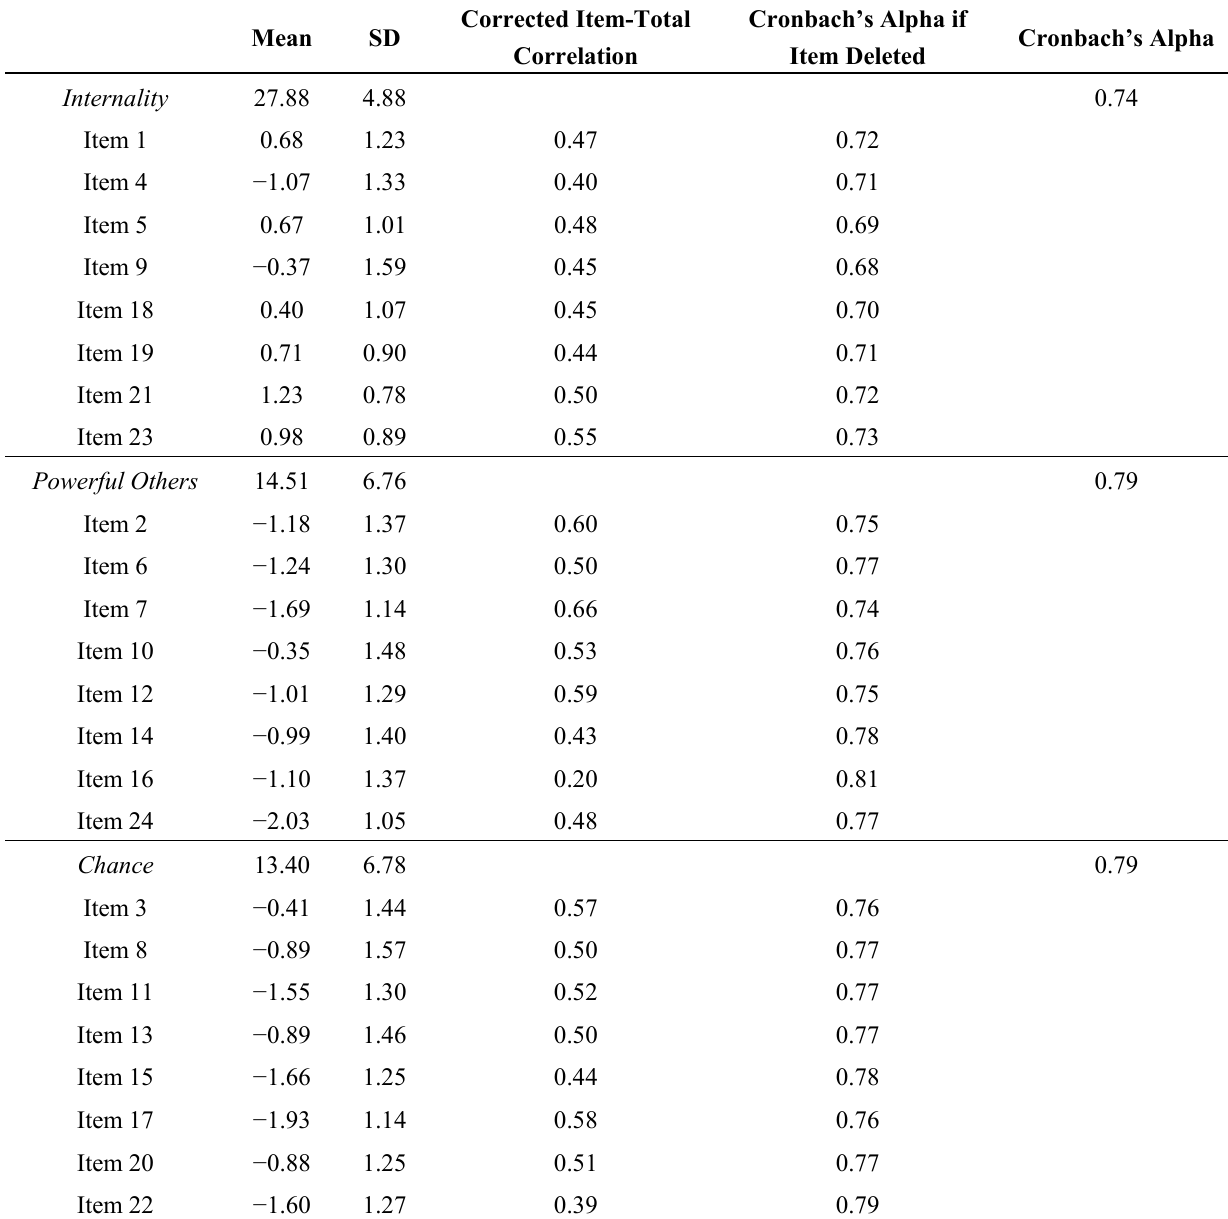
Table 2. Mean values, correlations, and Cronbach’s alpha